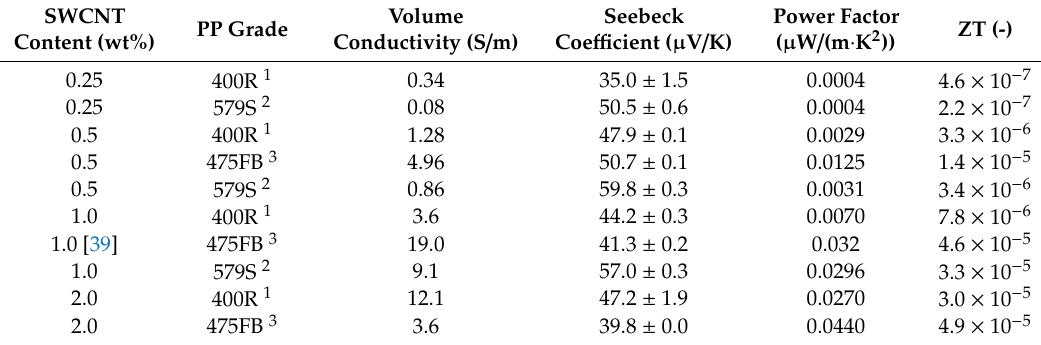
Table 3. Thermoelectric parameters for PP / SWCNT composites (same conditions for composite preparation), variation of PP matrix